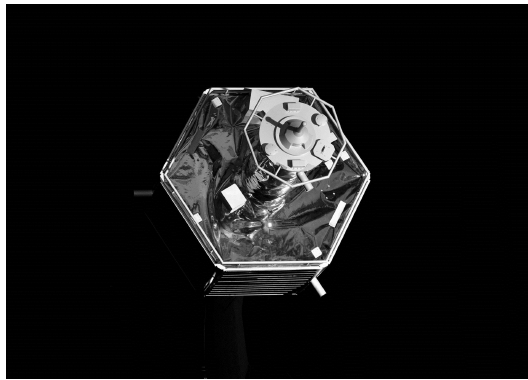
Figure 5: Gray-scaled image captured with a CCD camera. Due to the black curtain and black wrapping, very realistic images can be